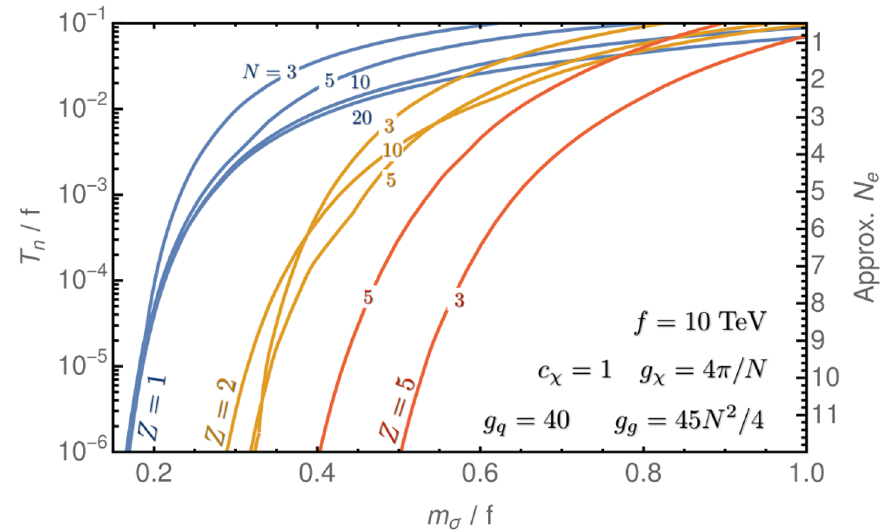
Figure 2 . Nucleation temperature, solution of eq. (2.21), after numerically solving the bounce action, as a function of the dilaton mass for different values of the kinetic rescaling factor, Z , and strong sector group SU( N ) rank. We see that strong supercooling is associated with a light dilaton. We set f = 10 TeV, c = 1 , and a dilaton-as-glueball inspired g = 4 π/N . With this scaling of g , χ χ χ increasing N leads to an increase in γ , which can counteract the thermal effects of the additional (cid:15) CFT bosons and lead to a weaker transition. For the same reason, large choices of Z , N , and m σ can also invalidate the perturbative analysis, which is why we restrict ourselves to smaller N for large Z . On the right axis we show approximate values for the number of e-foldings N , where we e use eq. (4.7) with m = 0 . 5 f , N = 5 and Z = 2 for definiteness (so the difference between the σ approximate N and the actual N is < 1 for the entire e e